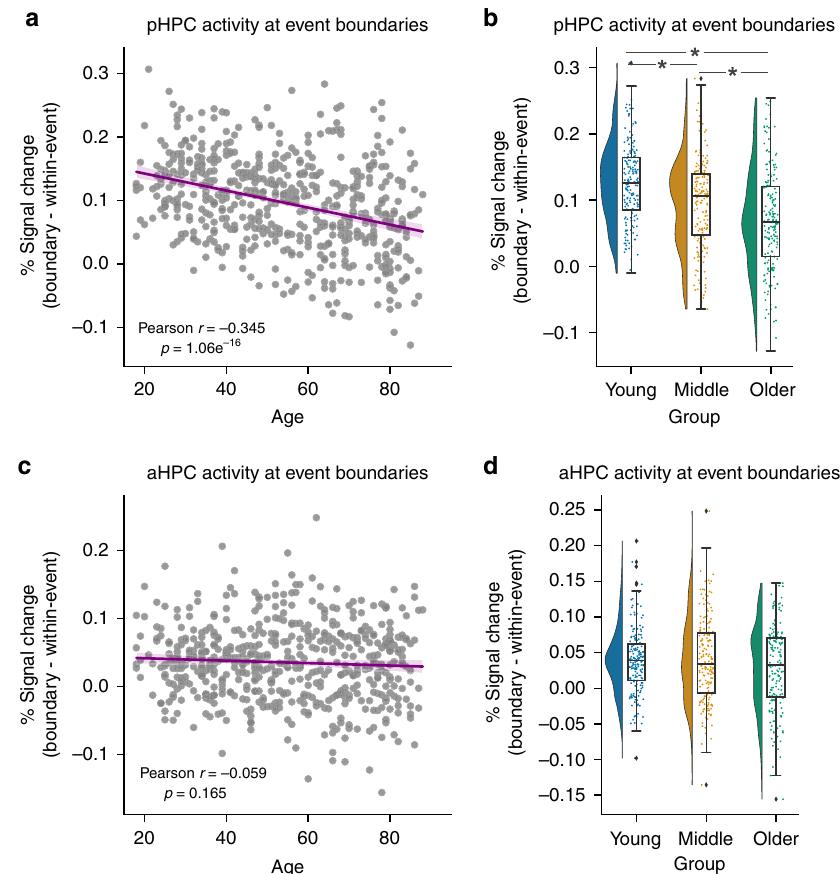
Fig. 1 Boundary-evoked activity and age-related decline in posterior hippocampus. a Activity at event boundaries signi fi cantly declines with age in pHPC. b This effect holds when grouping, and comparing across young, middle, and older individuals. No relationship between age and aHPC boundary-evoked activity was observed ( c ) nor any difference across age groups ( d ). (Correlations were assessed via Person ’ s r . * indicates a signi fi cant difference via Tukey ’ s HSD at p < 0.05 corrected following a one-way ANOVA. Raincloud plots depict data distributions across groups, with box components displaying median values and data quartiles. N = 546 for correlations, N = 182 per group for groupwise comparisons, examined over a single